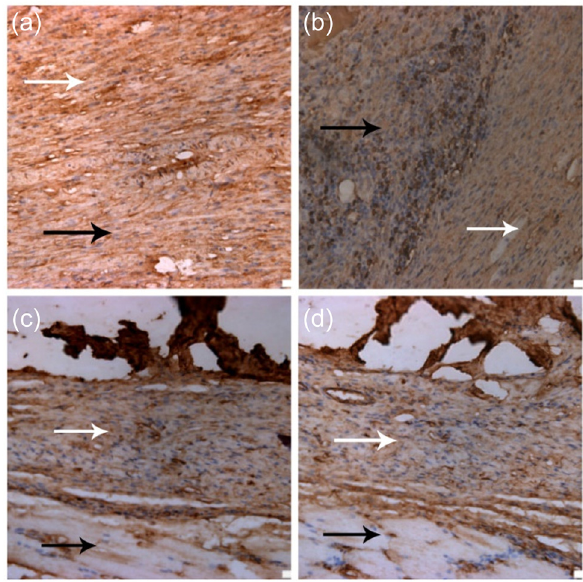
Figure 10: ICAM - 1 IHC staining of the Achilles tendons in rabbits and microscopic observation ( 200 ×) . ( a ) Group 1: the control group that received only normal saline; ( b ) Group 2: the group that received the bFGFp ( the plasmid with bFGF gene ) ; ( c ) Group 3: the group that received targeted microbubble ( the contrast agent with bFGFp and the target location factor, ICAM - 1 antibody ) ; ( d ) Group 4: the group that received the microbubbles with the bFGFp. ( Black arrows indicate the external tendon sheath. White arrows indicate the internal tendon sheath. )